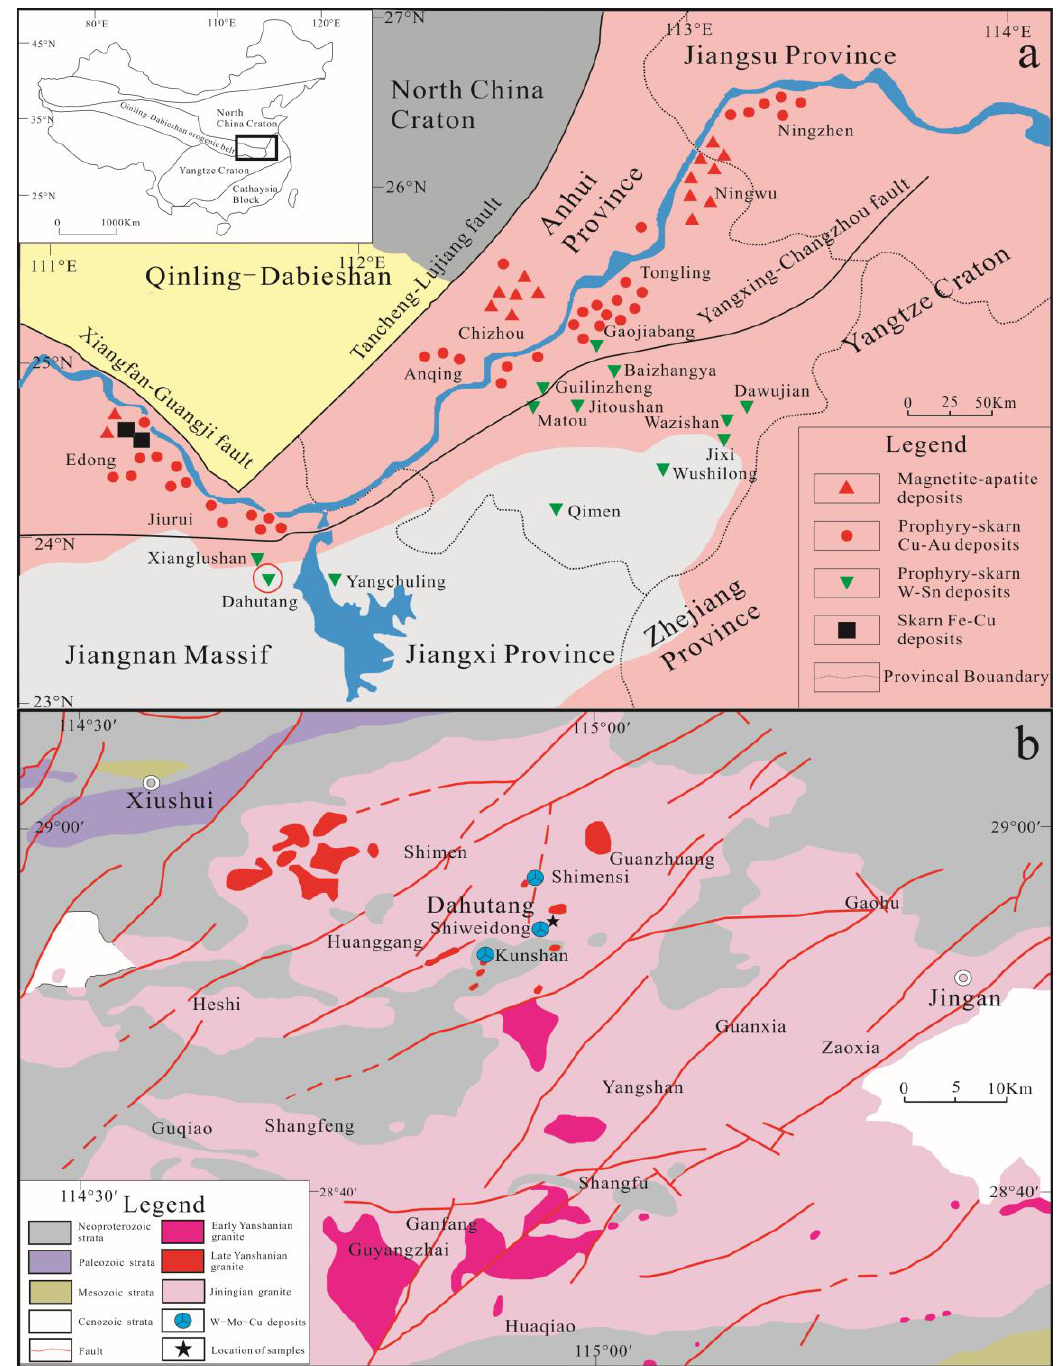
Figure 1. ( a ) Distribution of ore clusters (districts) in the Middle and Lower Yangtze River metallo- genic belt and deposits in the Jiangnan tungsten belt (the insert shows the general tectonic divisions of China, the black rectangle indicates the position of Figure 1a and the circled triangle represent the location of the Dahutang deposit.) (modified after [5]); ( b ) Sketch geological map of the Dahutang tungsten polymetallic mine region and the surrounding area in northwestern Jiangxi Province, South China (modified after [31]).